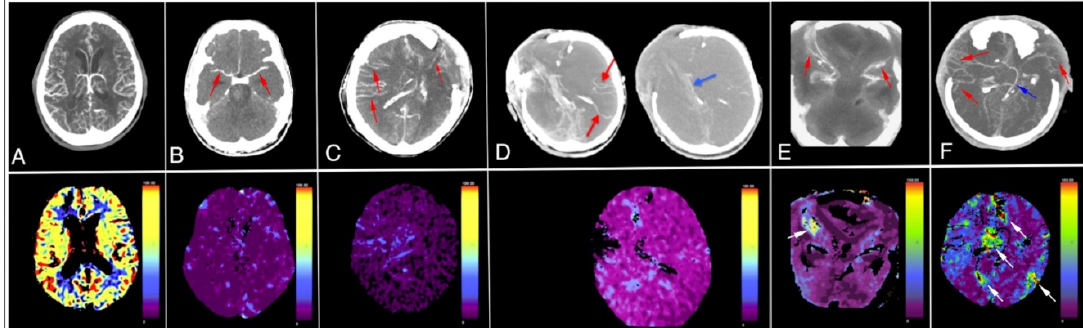
Figure 3. Different CTA (upper row) and CTP (lower row) patterns during CCA diagnosis procedures: ( A ) patient with suspected ischemic stroke with normal CTA and CTP; ( B ) patient with opacification limited to proximal segments of middle cerebral arteries MCA-M1 inCTA (red arrows) and CBF value < 10 mL/100 g/min in CTP; both techniques confirm CCA. ( C ) Patient with bilateral opacification of cortical arterial segments (MCA-M4; red arrows) in CTA, not consistent with CCA diagnosis and CBF value < 10 mL/100 g/min in CTP, which confirms CCA diagnosis; ( D ) patient with opacified MCA-M4 segments (red arrows) and opacified internal cerebral vein (blue arrow) in CTA, not consistent with CCA diagnosis and CBF value < 10 mL/100 g/min, which confirms CCA diagnosis; ( E ) patient with opacified MCA-M2/M3 segments (red arrows) in CTA, consistent with CCA diagnosis and isolated single sub-craniectomy area with CBF value > 10 mL/100 g/min (white arrow), also consistent with CCA diagnosis; ( F ) patient with opacified MCA-M4 segments (red arrows) and opacified internal cerebral vein (blue arrow) in CTA, not consistent with CCA diagnosis and multiple scattered areas with CBF value > 10 mL/100 g/min (white arrows), also inconsistent with CCA diagnosis. Color scales illustrate range of CBF (mL/100 g/min). CBF < 10 mL/100 g/min confirms CCA.